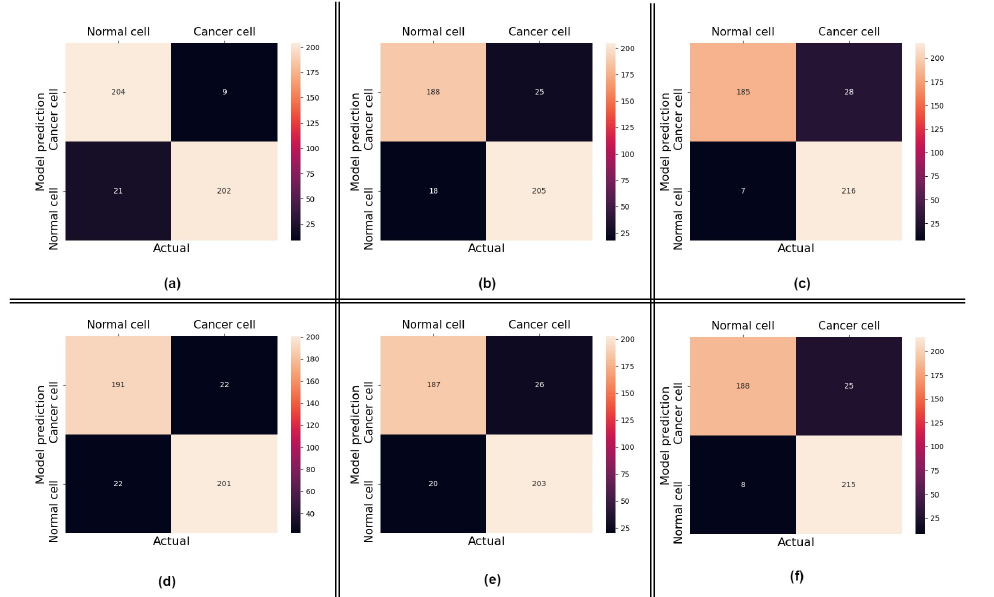
Figure 7. The confusion matrices obtained from different folds in our proposed model. ( a ) shows the confusion matrix ordained from fold-1, ( b ) the fold-2 confusion matrix, ( c ) the fold-3 confusion matrix, ( d ) the fold-4 confusion matrix, ( e ) the fold-5 confusion matrix, and ( f ) the fold-6 confusion matrix for the classification of ALL cell